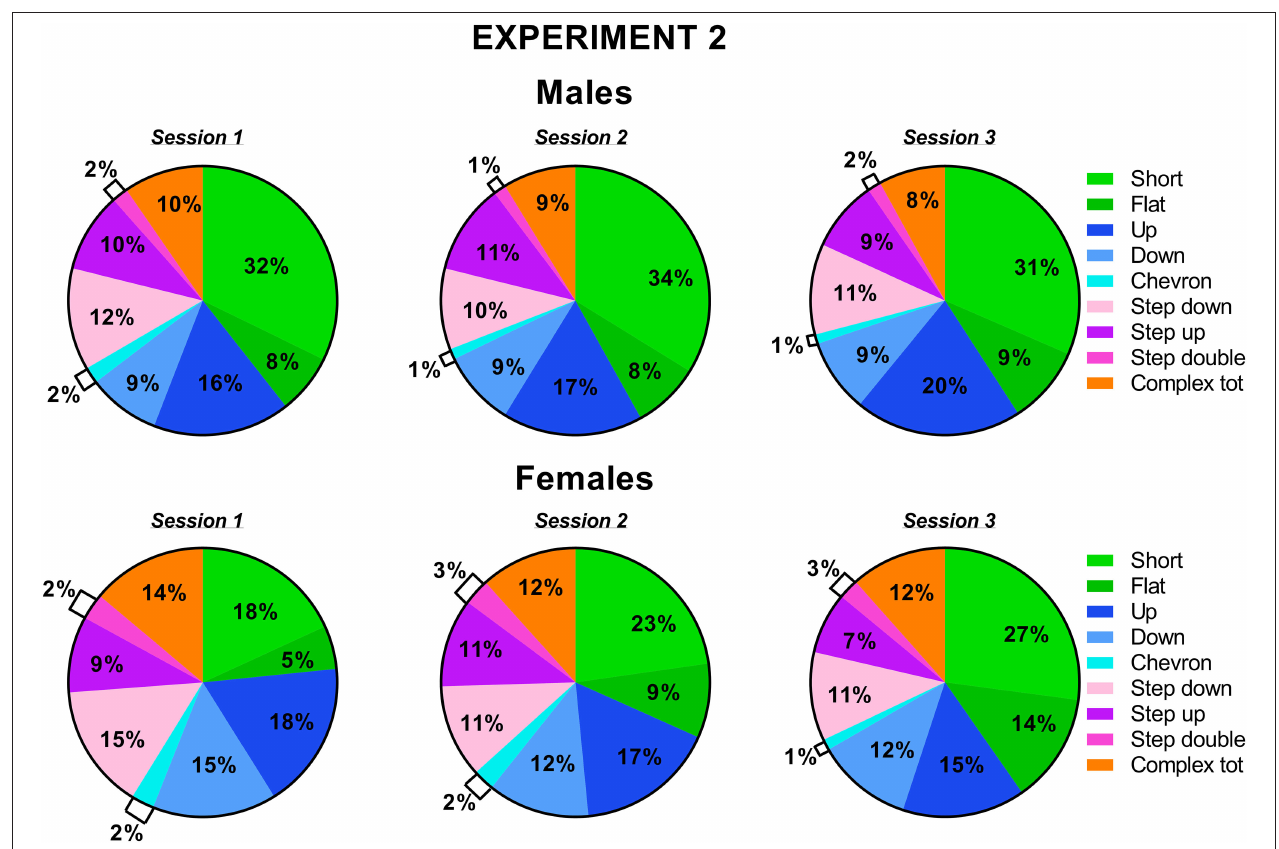
FIGURE 8 | Pie charts depicting sex differences in ultrasonic call types in experiment 2 (different pre-testing isolation). Distribution of call categories in each sex and testing session. Data are expressed as percentages over the total number of USVs for each sex and session. Data are mean ± SEM. N = 10 for each sex. Complex tot = complex 3 + complex 4 + complex 5 (refer also to Figure 1